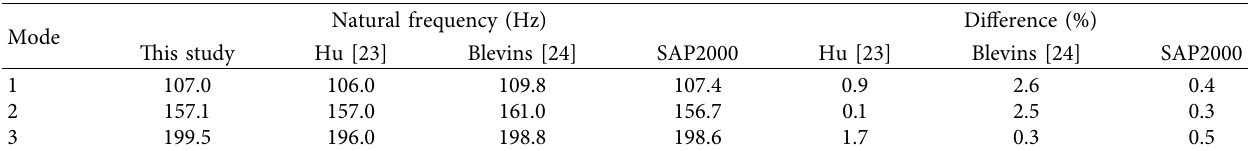
Table 3: Comparison of natural frequencies.